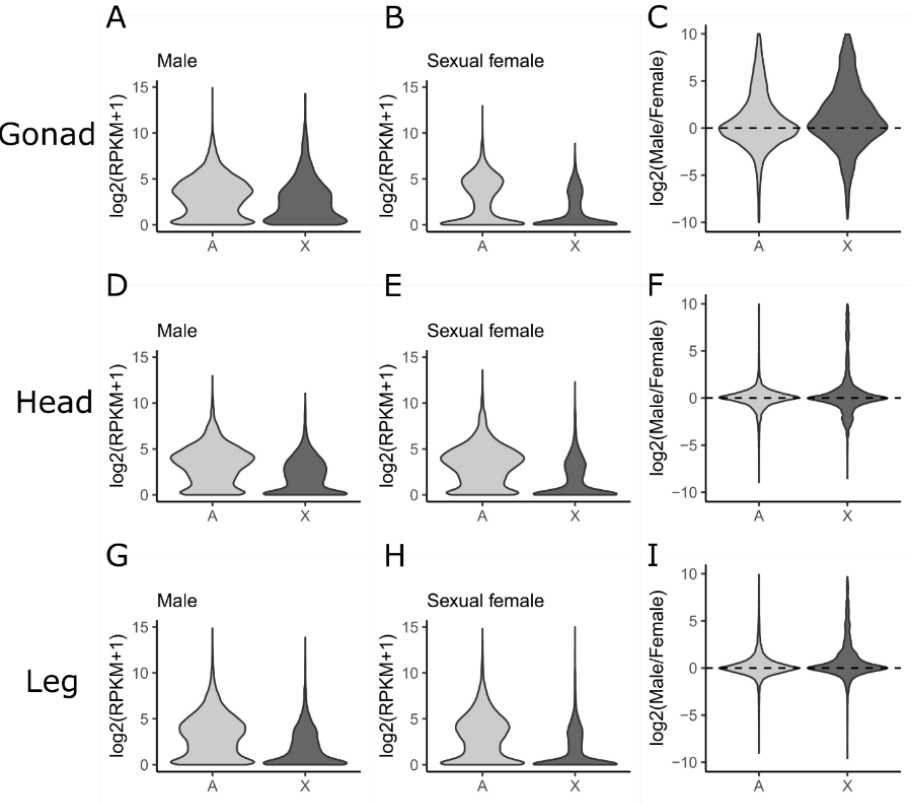
Figure 4: Logarithm of gene expression (RPKM, reads per kilobase per million mapped reads) for X-linked and autosomal genes for the different types of libraries (gonads, heads or legs of males and sexual females). X-linked genes are significantly less expressed than autosomal genes in all cases (two-sided Mann-Whitney tests, p < 10 -15 ). Logarithm of male-to-sexual female ratio of RPKM is also shown for the three different